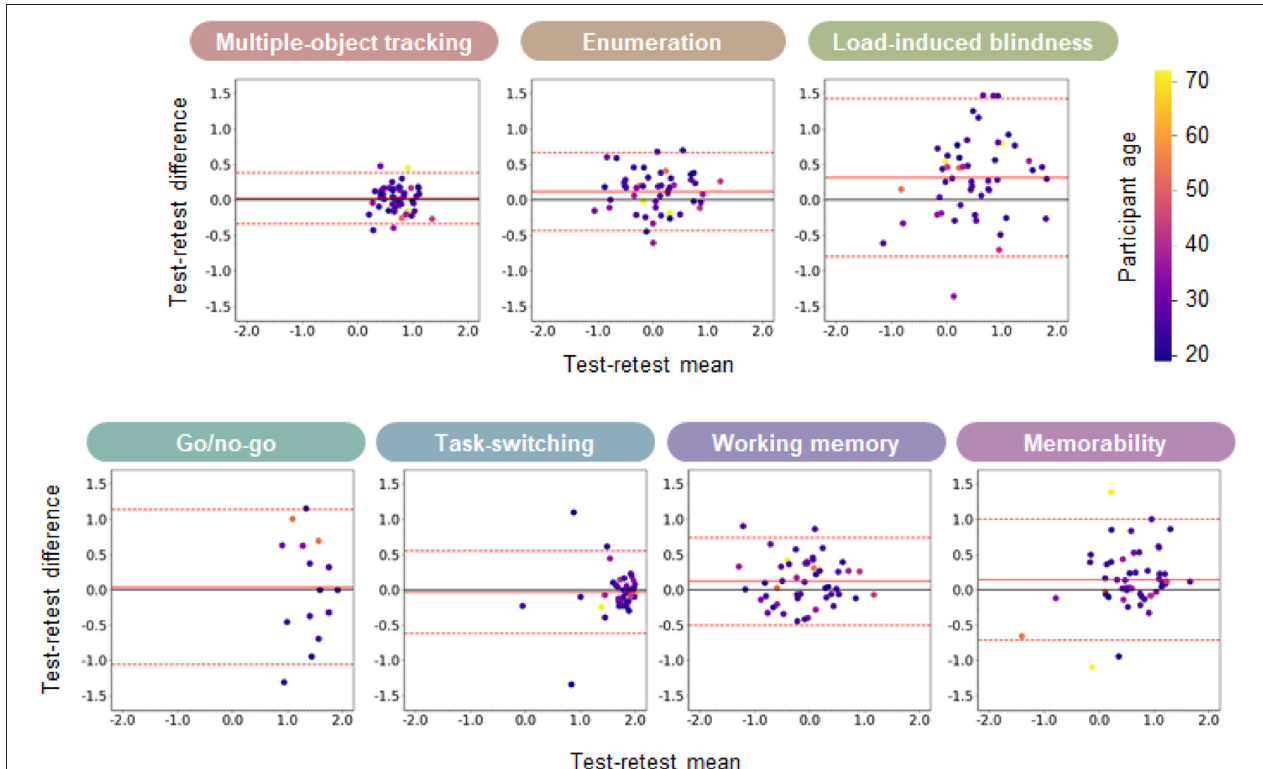
FIGURE 6 | Bland-Altman plot for the accuracy data. Each participant’s performance difference was plotted as a function of the mean performance of the 2 days. Different colors indicate different participant ages. The accuracy data is converted to the inverse normal cumulative distribution function, as in the latent factor analysis. The positive difference means that the second day performance is better than the first day. The solid red line indicates the mean difference across participants, while the dashed red line indicates the ± 1.96 SD of the differences.